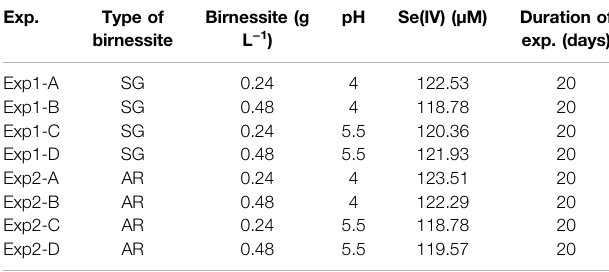
TABLE 1 | List of experimental conditions with concentrations at t=0 1 .